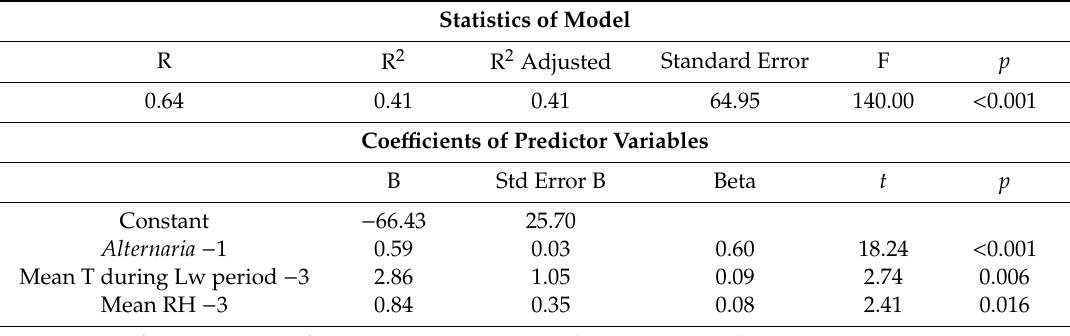
Table 7. Summary of linear regression analysis to predict Alternaria